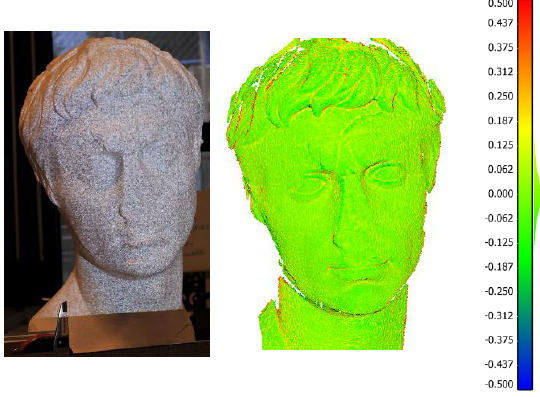
Figure 6: An example of random pattern projected onto the Augusto face to allow 3D dense image matching (left) and a comparison with a ground truth data (right).